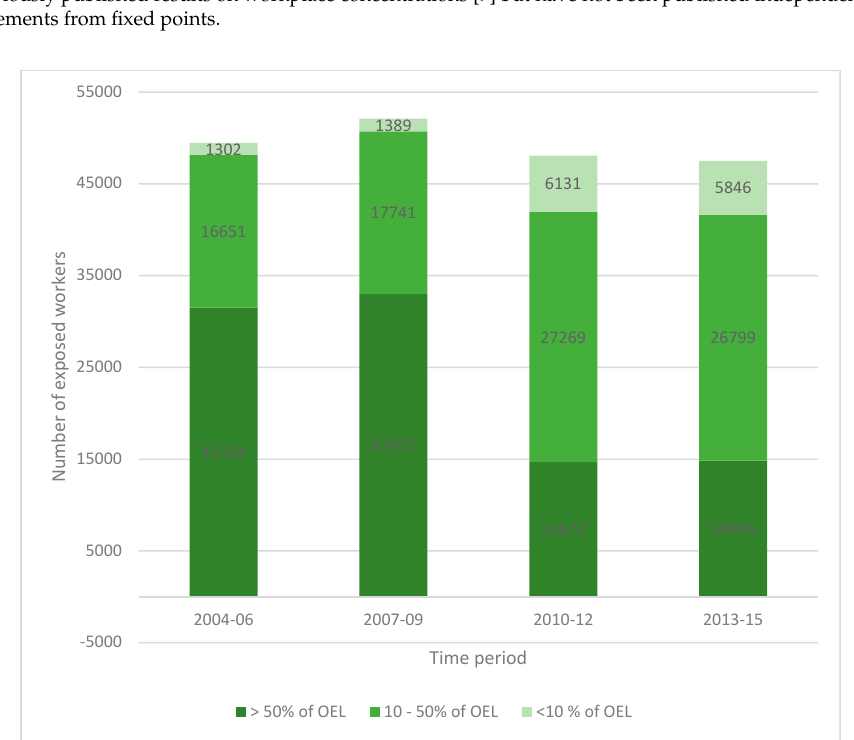
Figure 2. Number of workers estimated to be exposed to respirable quartz in Finland during 2004–2015.